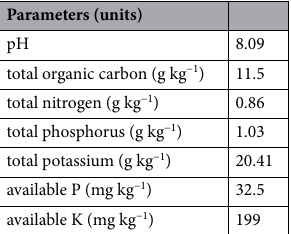
Table 5. Main characteristics of the soil (0–20 cm) before the start of the